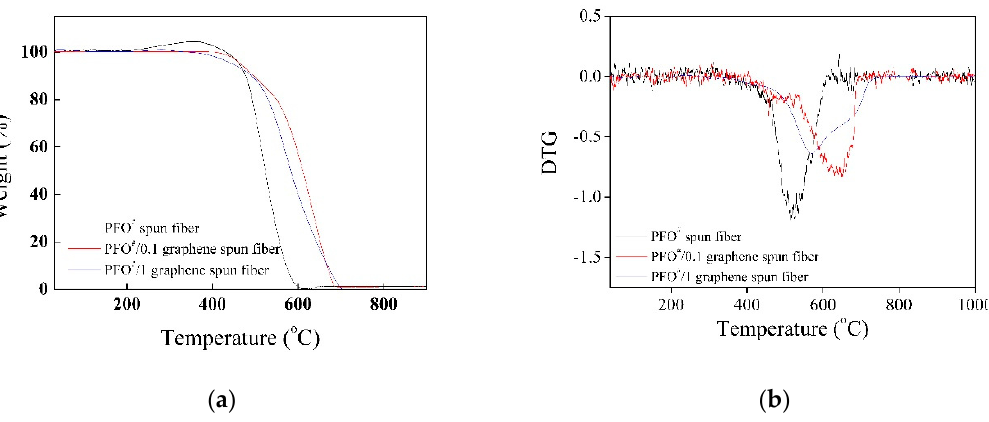
Figure 2. Thermal analysis of PFO # -based fibers before and after graphene addition; ( a ) TGA, ( b ) DTG .